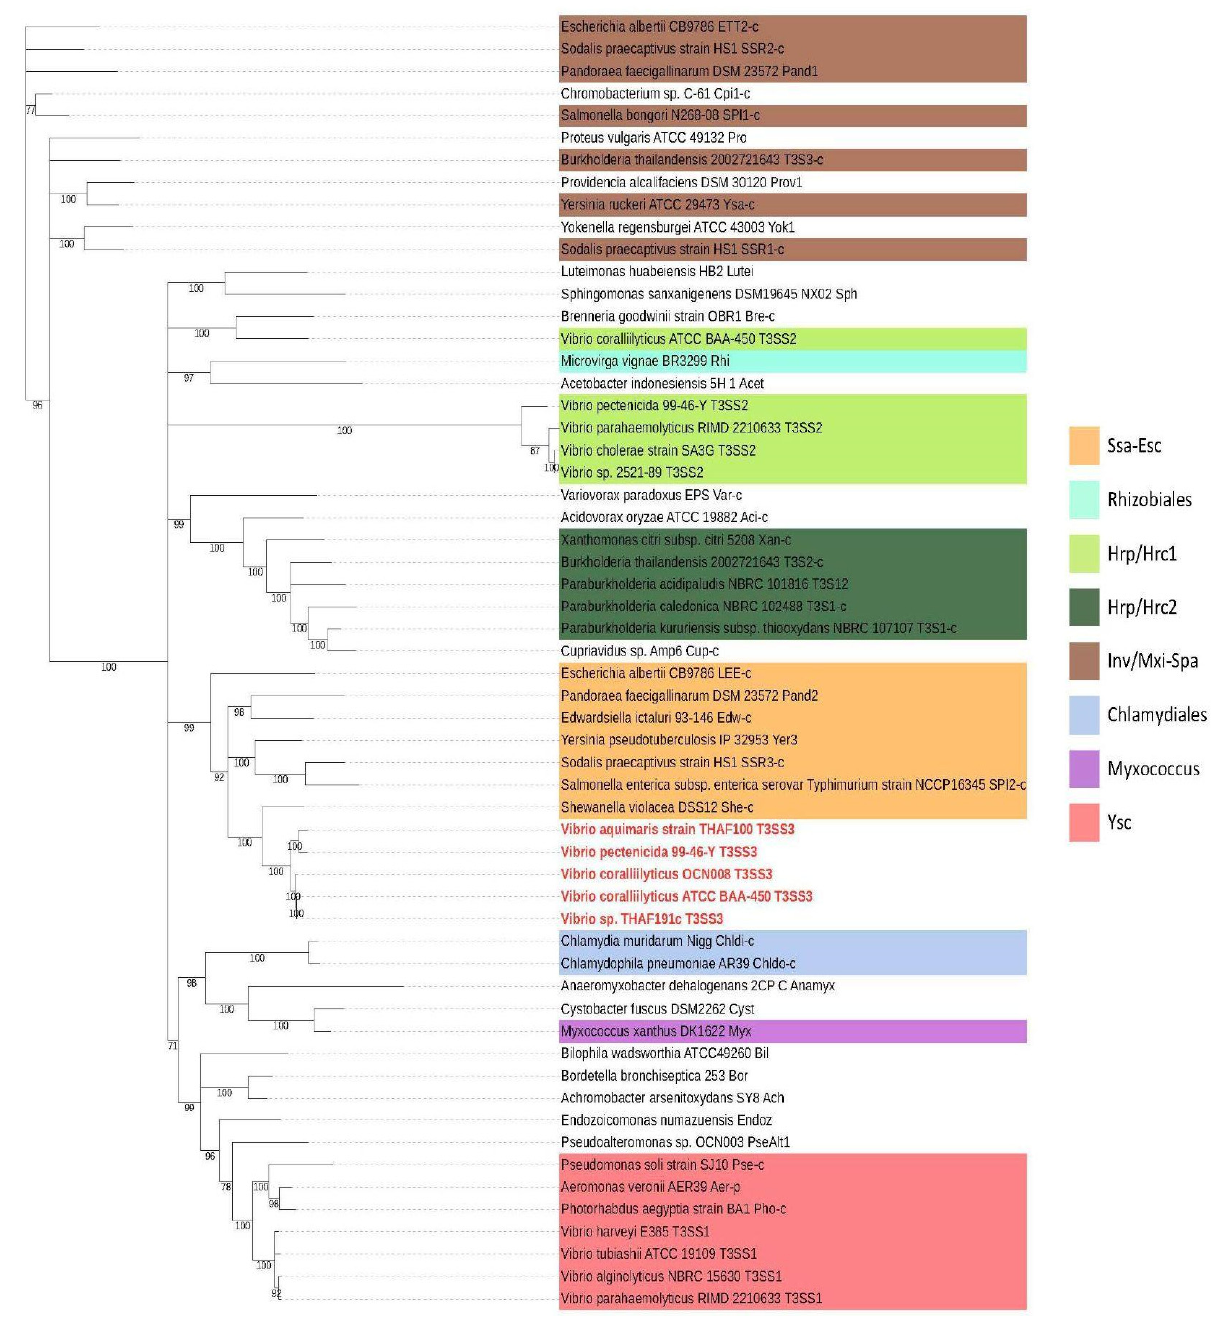
Figure 2. Phylogenetic tree of concatenated SctN-SctS-SctU-SctV proteins for bacteria with T3SS. Vibrio strains possessing a T3SS3 cluster are marked in red. V. coralliilyticus ATCC BAA-450 was added, in addition to the well-studied OCN008 strain, as the type strain possessing T3SS. Background colors show 8 T3SS families previously proposed for a subset of species analyzed [6,8].